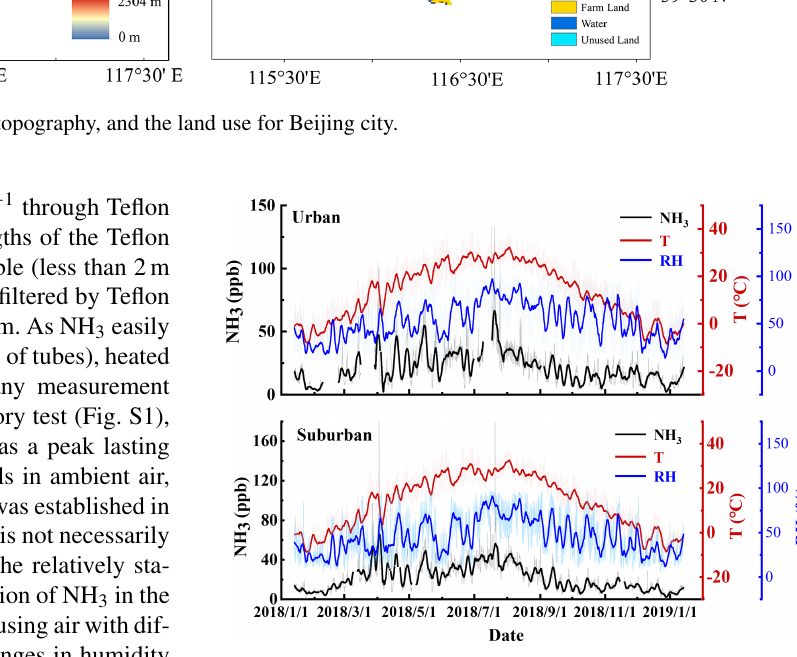
Figure 2. Temporal variations in the hourly average NH 3 mixing ra- tios, temperatures ( T ), and relative humidity (RH) at the urban and suburban stations in Beijing. Continuous thick lines were smoothed with 168 points (7d) using the Savitzky–Golay